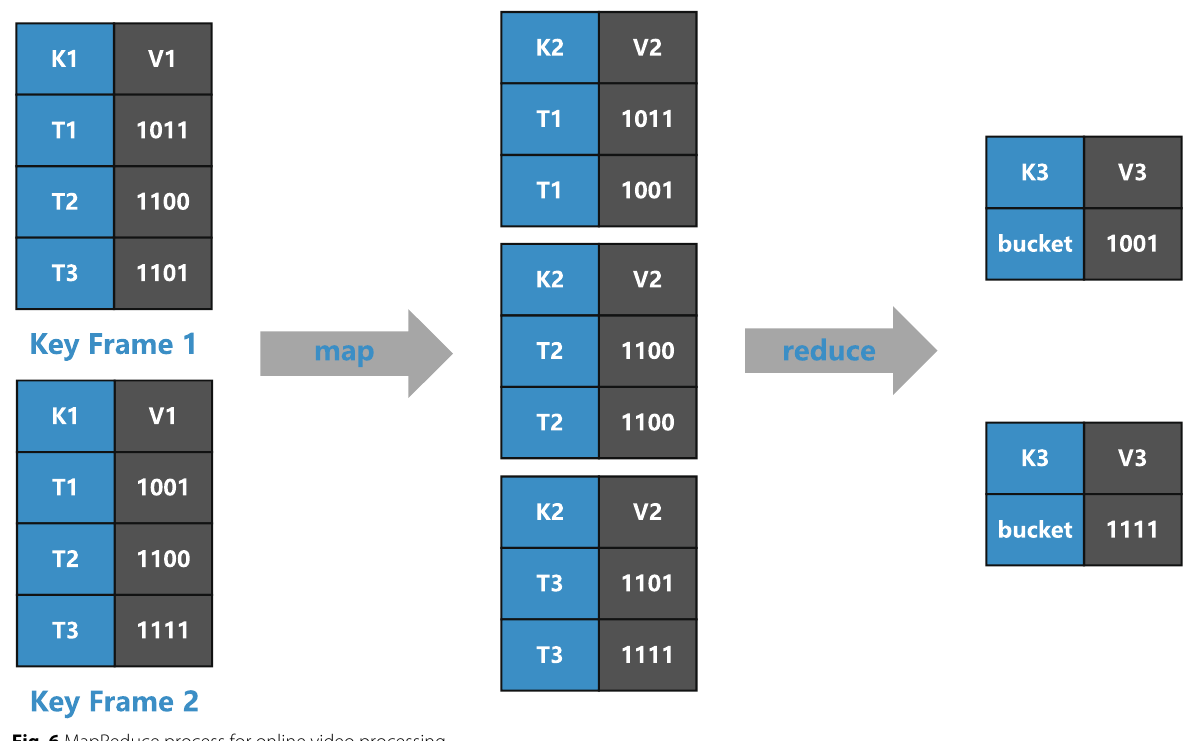
Fig. 6 MapReduce process for online video processing